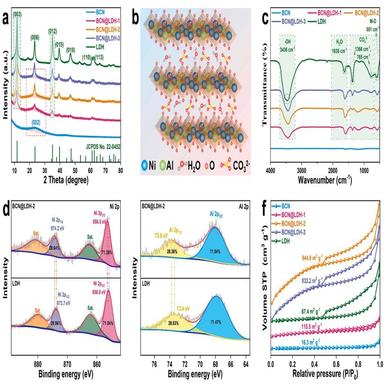
(a) XRD patterns of BCN, BCN@LDH-1, BCN@LDH-2, BCN@LDH-3 and LDH. (b) Crystal structure of NiAl-LDH-CO3 2-. (c) FT-IR spectra of BCN, BCN@LDH-1, BCN@LDH-2, BCN@LDH-3 and LDH. (d) Ni 2p and (e) O 1s core-level XPS spectra of BCN@LDH-2. (f) BET surface area of BCN@LDH-2.